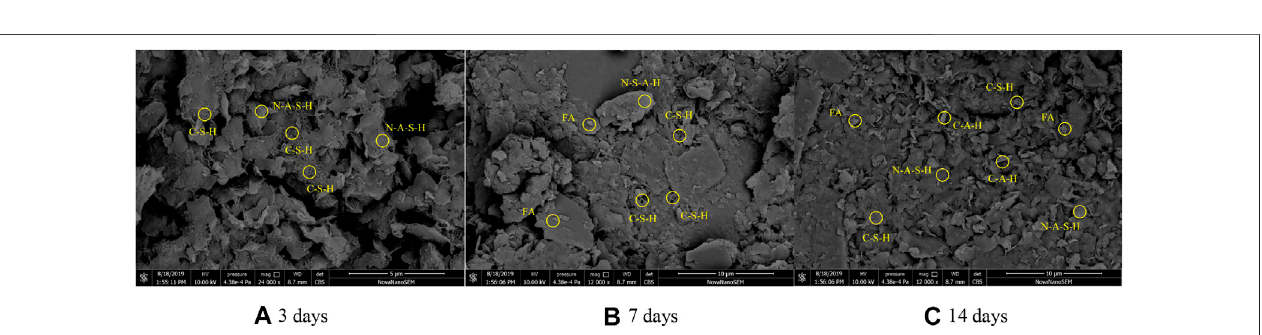
FIGURE 10 | SEM image of the one-part geopolymer-stabilized soft clay with 80% GGBFS and 20% FA at 6.50 mol/L NH solution: (A) 3 d; (B) 7 d; (C) 14 d.